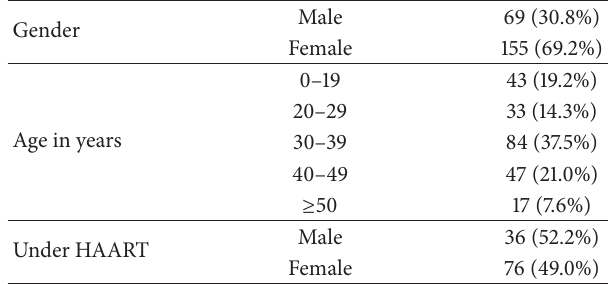
Table 2: Demographic characteristics of study subjects.